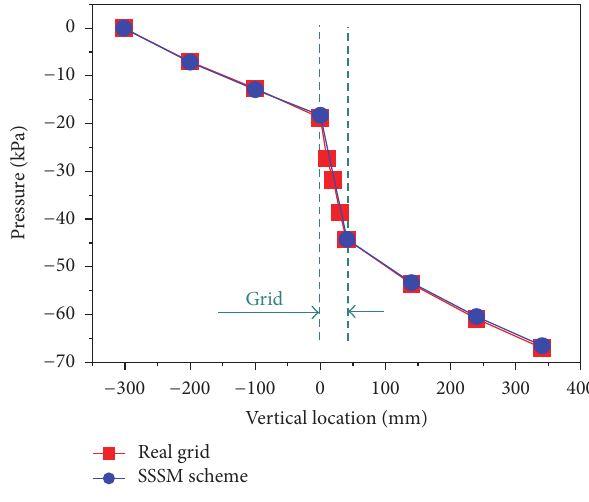
Figure 29: Pressure profile along vertical direction. Figure 30: Pressure profile using SSSM scheme.